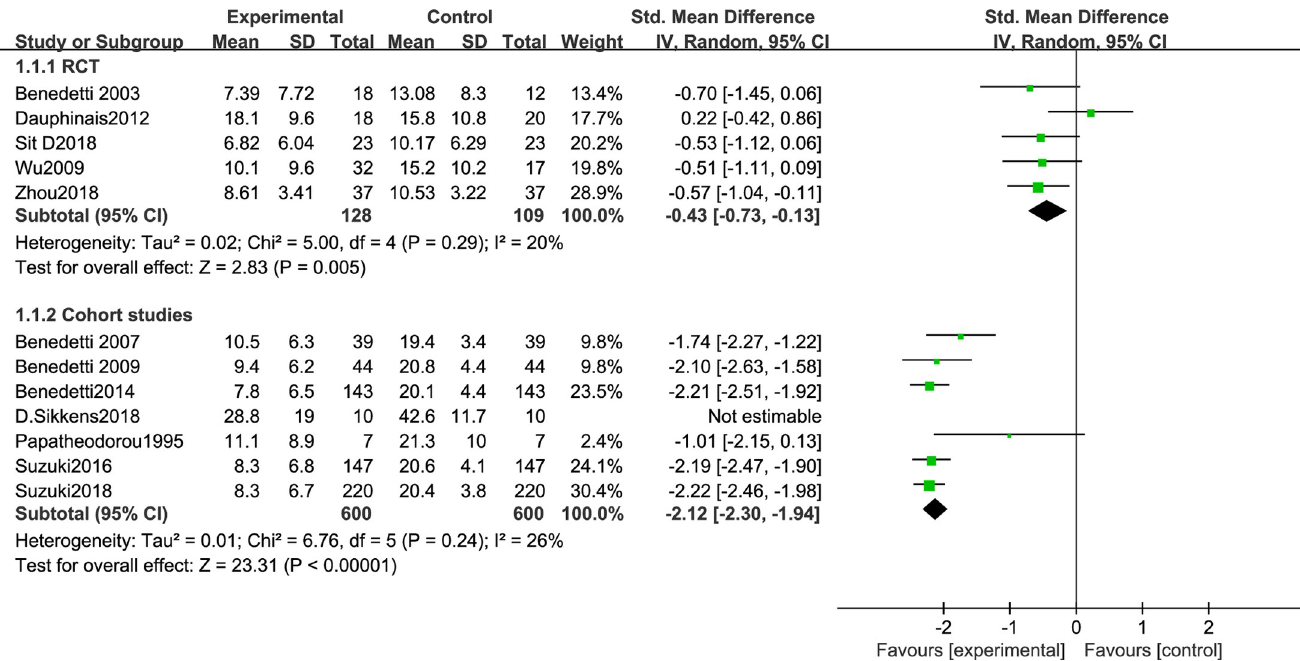
Fig 2. Meta-analysis results of depression severity in RCT group and cohort study group.